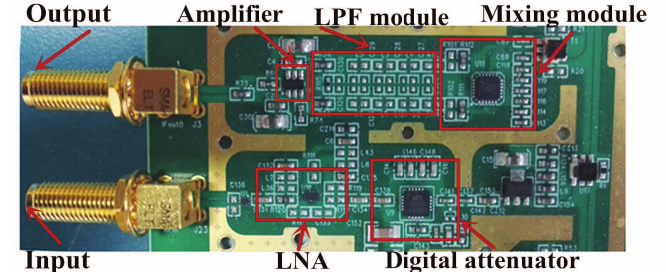
Figure 9. Photograph of the circuit